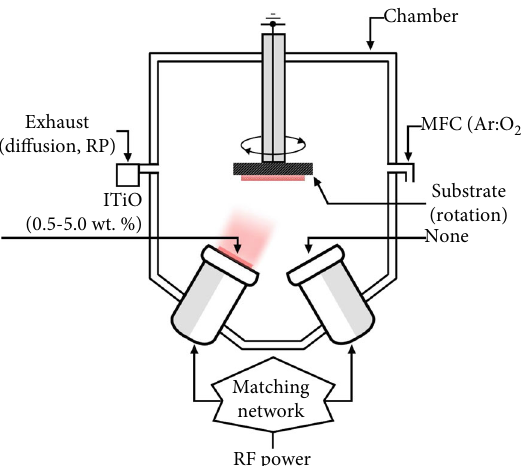
Figure 1: Schematic diagram of dual-target type by the radio frequency magnetron sputtering